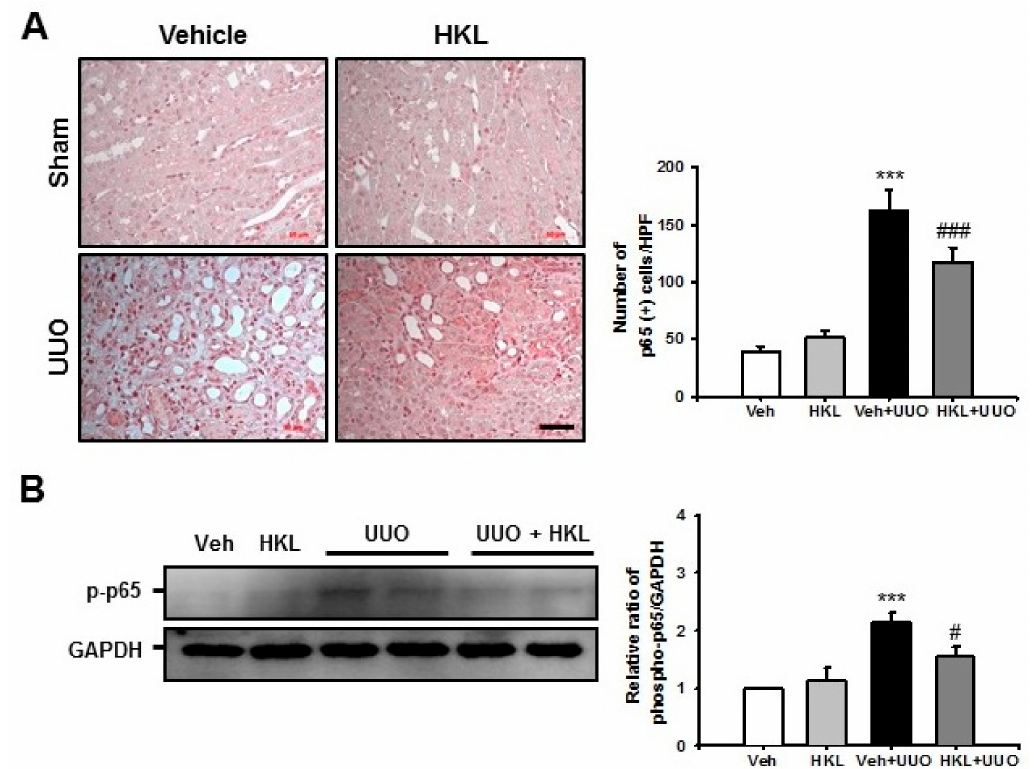
Figure 4. E ff ect of honokiol on nuclear factor- κ B (NF- κ B) signaling pathway after ureteral obstruction. ( A ) Representative sections of kidneys from sham- and unilateral ureteral obstruction (UUO)-operated mice treated with vehicle (Veh) or honokiol (HKL) were stained with p65. Scale bar = 50 µ m. The